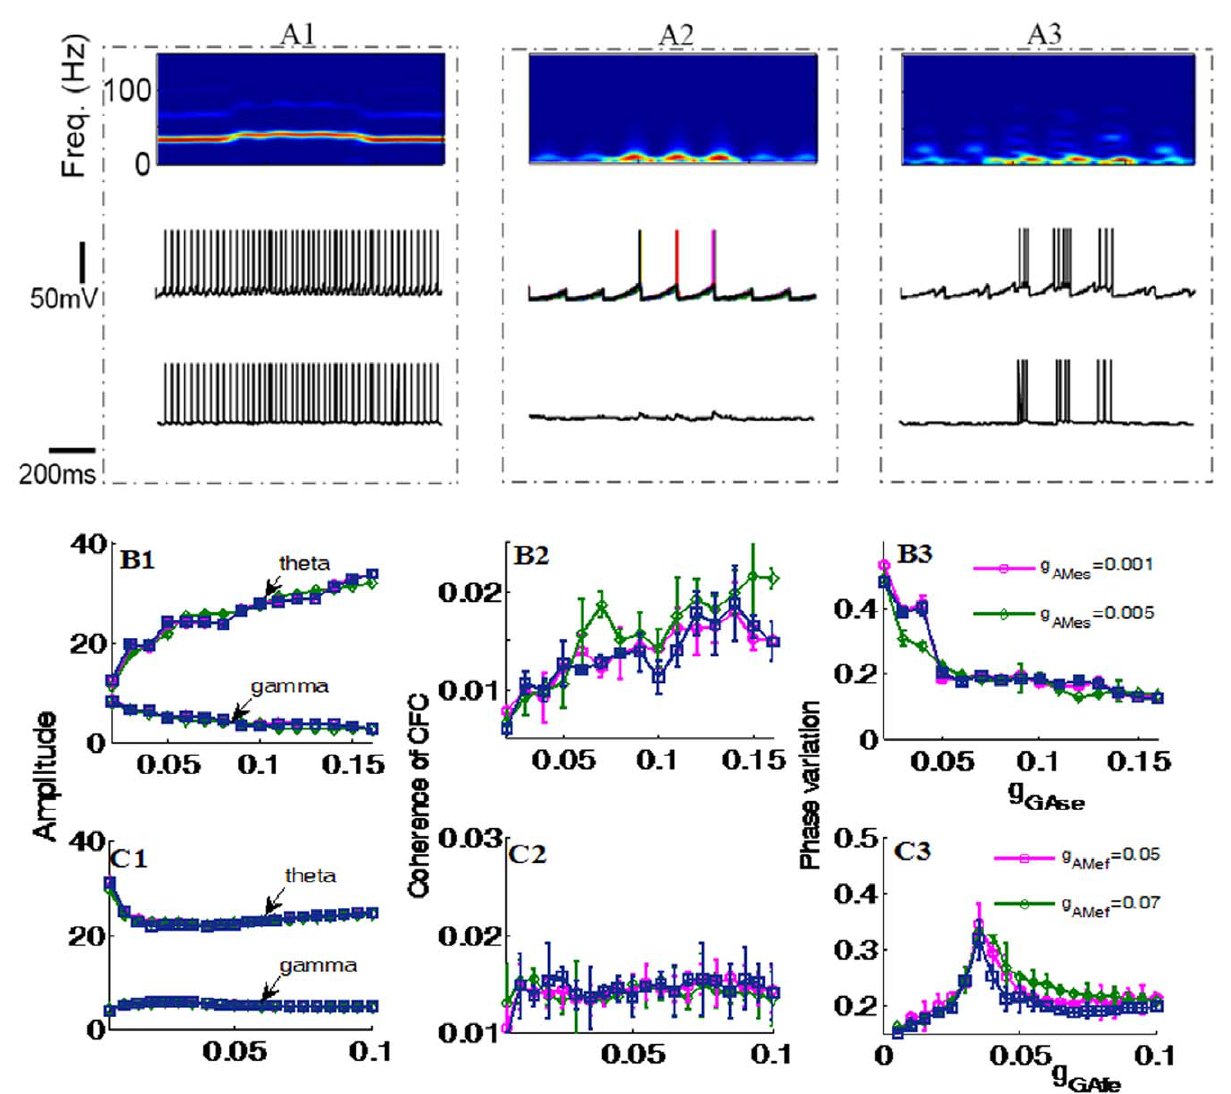
Figure 2. Coordinated regulation of GABA A,fast and GABA A,slow currents is the key for generating theta-nested gamma oscillations. (A) Three different response behaviors of the network to a stimulus: (A1) Only gamma rhythm (by blocking INs R EX connection); (A2) only theta rhythm (by blocking INf R EX connections); (A3) theta-nested gamma rhythm (in the presence of both INs R EX and INf R EX connection). The three traces from the upper to the bottom are the time-frequency power spectrum, the firing behaviors of EX cells and the firing behavior of a downstream neuron, respectively. (B-C) Effects of increasing g g GAse and g GAfe on the theta and gamma amplitudes, the coherence of cross-frequency coupling, the tightness of theta